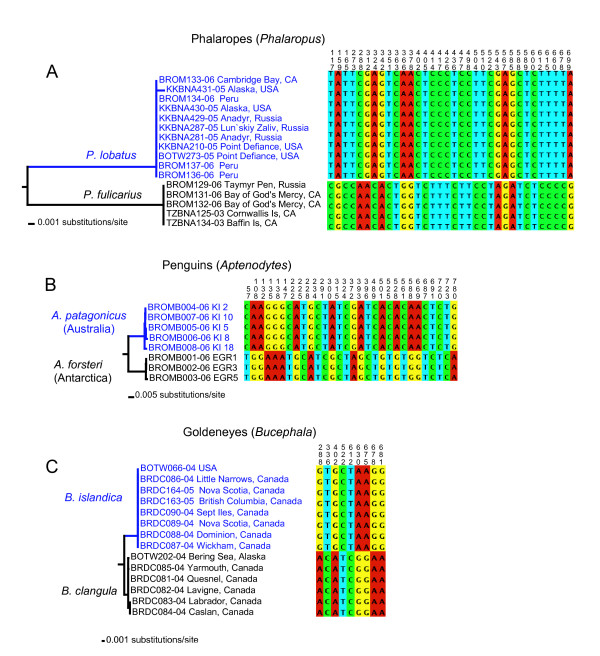
Examples of DNA barcodes distinguishing sister species. Neighbor-joining tree constructed with K2P genetic distances. Fixed substitutions are represented by coloured boxes, with corresponding character positions relative to the beginning of COI. a) Phalaropes (Phalaropus); b) Penguins (Aptenodytes); c) Goldeneyes (Bucephala).